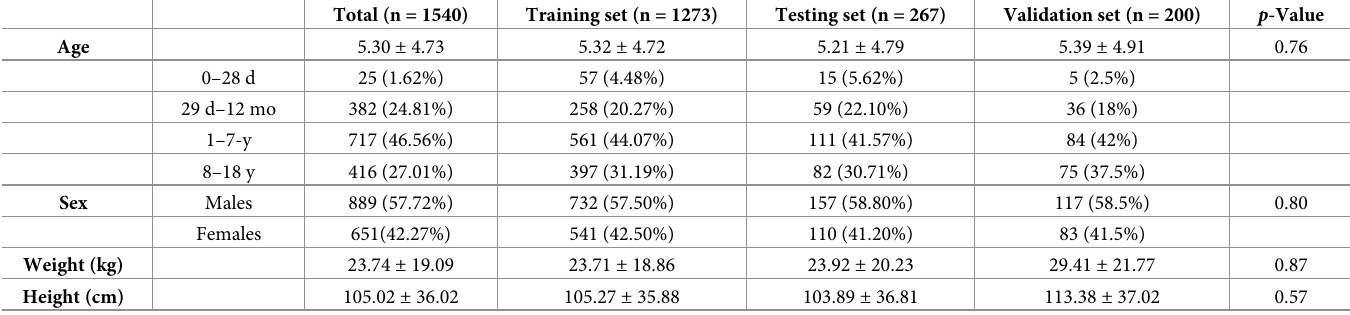
Table 1. Baseline characteristics in the